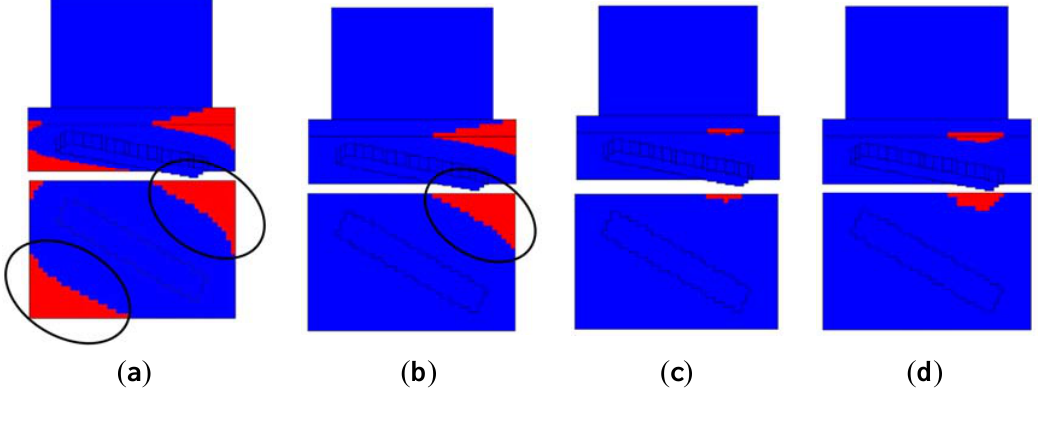
Figure 10. The IUZ distributions of the four simulation groups ( a ) SG1; ( b ) SG2; ( c ) SG3; ( d ) SG4. The upper figures are side views in 3D, and the lower figures are the vertical views of the